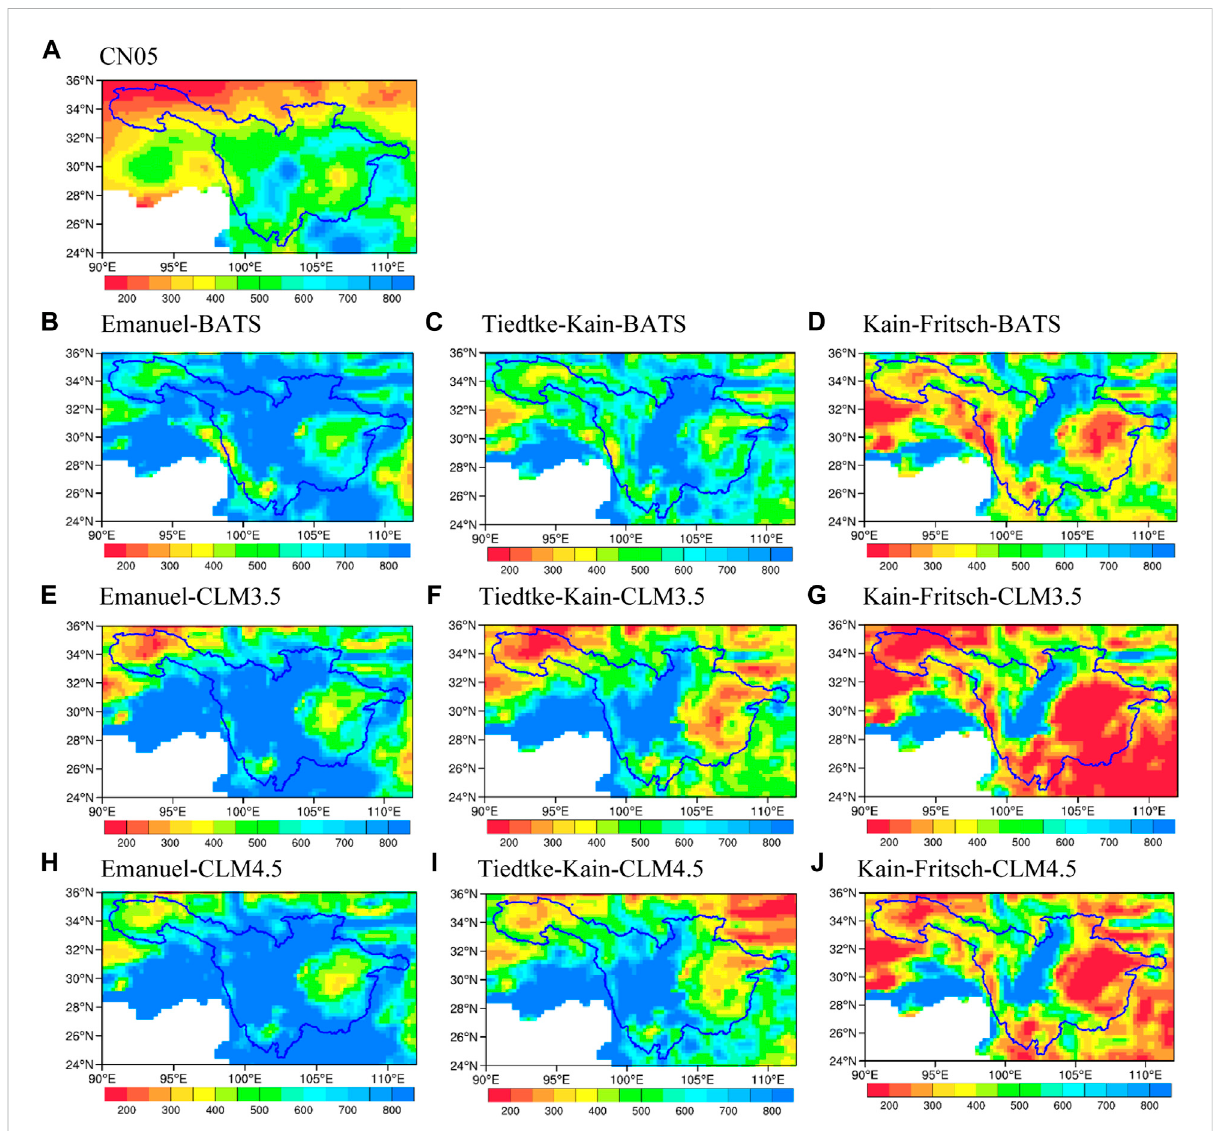
FIGURE 4 Spatial distribution of observed and simulated multi-year average summer total precipitation (unit: mm) for the current climate (1991 – 1993) over the UYRB. [ (A) CN05, (B) simulation of the combination scheme of Emanuel and BATS, (C) simulation of the combination scheme of Tiedtke- Kain and BATS, (D) simulation of the combination scheme of Kain-Fritsch and BATS, (E – G) same as (B – D) but for CLM3.5, and (H – J) same as (B – D) but for